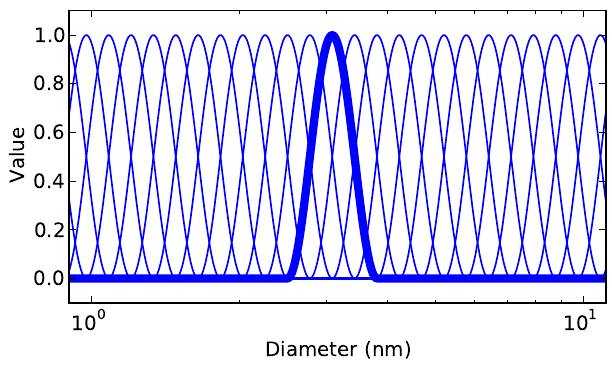
Fig. 7. Part of a typical set of elementary distributions used for NAIS with one distribution highlighted. Commonly, cos 2 x in the , π ] is used as the shape for the range [ − π 2 2